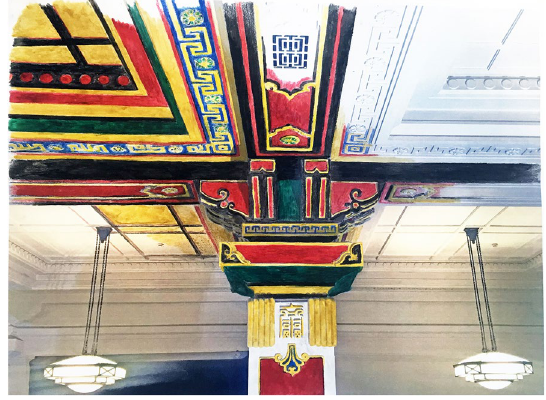
Fig. 10 The Chinese Banking Hall with a montage of the coloured decoration to visualise the colour scheme found for the room decoration through on-site investigation and stratigraphy.